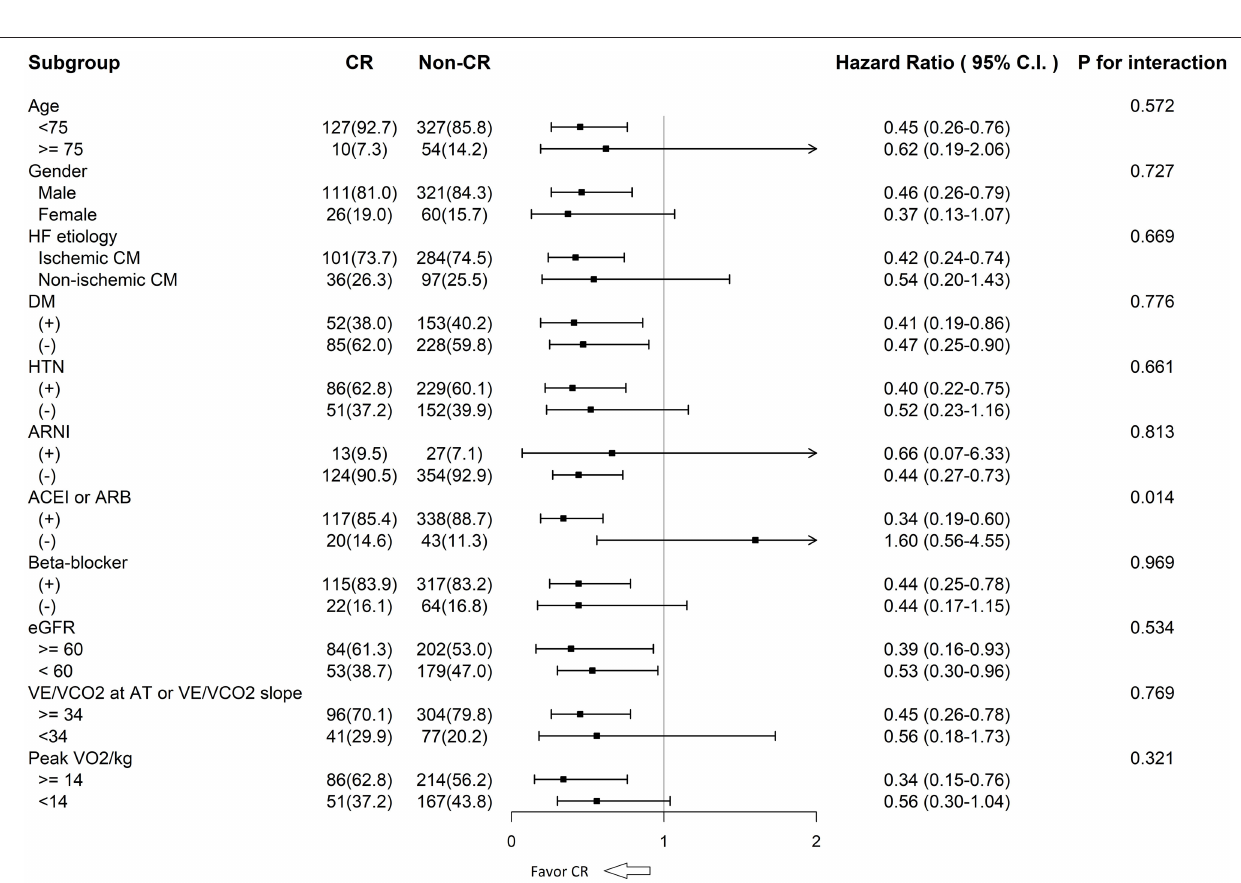
Frontiers in Cardiovascular Medicine |